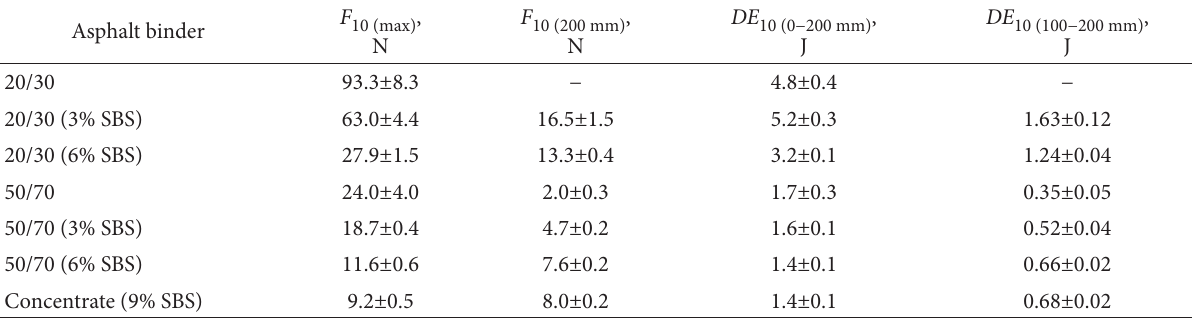
Table 4. Tensile force and deformation energy of the tested binders determined at 25 °C Asphalt